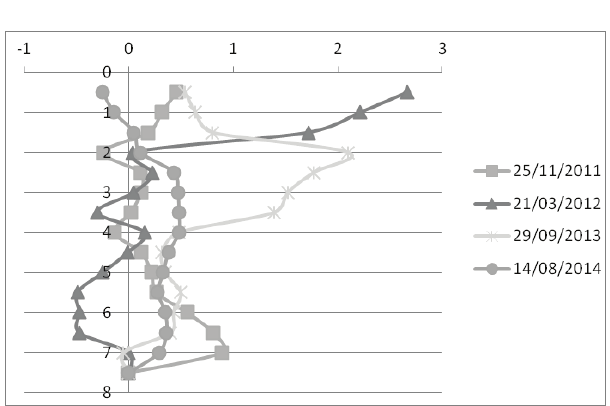
Fig. 6. Displacements from inclinometer measurements over time, measurement point